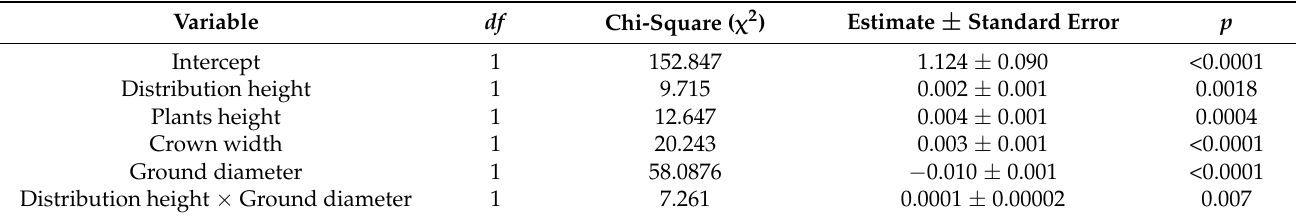
Table 1. Results of the generalized linear model (GLM) for the number of individual larvae of C. aeruginosa as a function of their location at different heights on the plants of A. ordosica and morphological characteristics (plant height, crown width, and ground diameter).